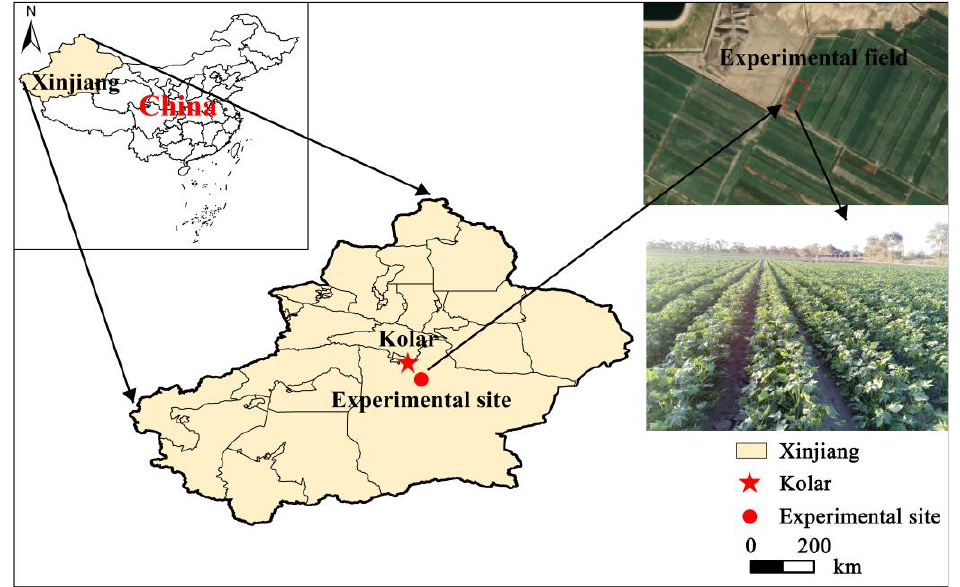
Figure 1. Location of the experimental site in Korla, Xinjiang, China. The soil in the 0~60 cm zone was mainly sandy loam and silt loam, while the soil in the 60~100 cm zone was mainly sandy; some soil physical properties and chemical properties in the 0~100 cm zone are shown in Table 1. The average bulk density in the rootzone (0~60 cm) was 1.57 g · cm − 3 , while the average FC (volumetric water content) was 30.57%; moreover, the soil field water capacity declined in the 0~40 cm and 40~100 cm zones. The average initial soil salinity in the 0~100 cm zone was 0.52 g · kg − 1 and increased from the 0 cm to 100 cm soil layers. The content of NO 3 -N and NH 4 -N in the rootzone (0~60 cm) was 14.28 and 8.64 mg · kg − 1 ,